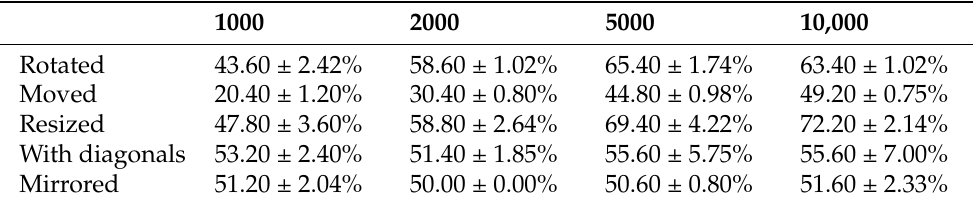
Table 11. The number of transformed objects: 5; Level of noise: